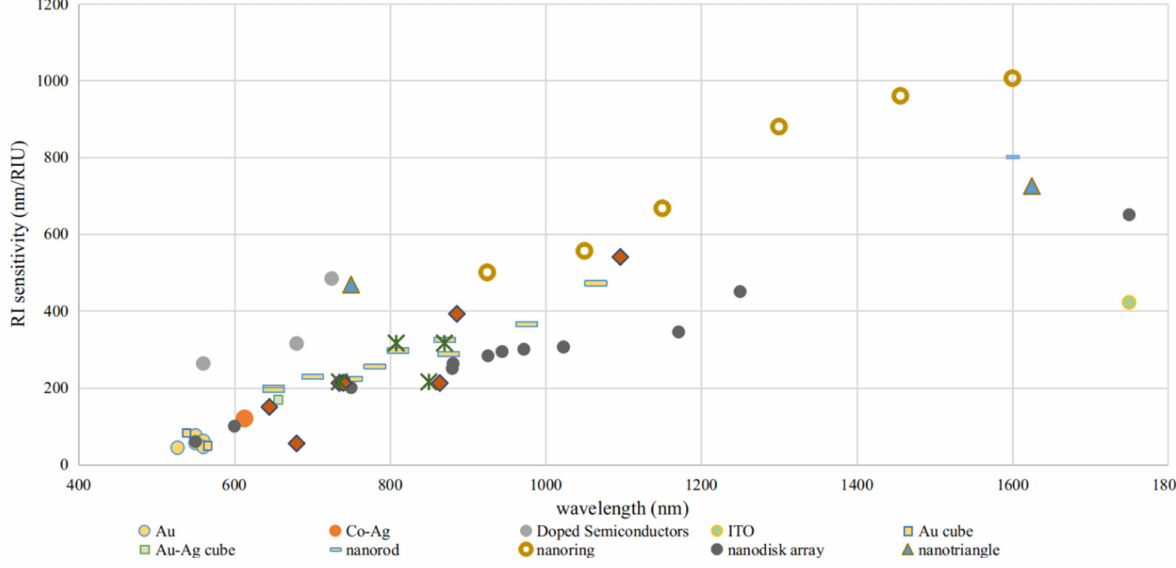
Figure 18. Sensitivity vs. wavelength comparison for the most performant nanostructures towards NIR